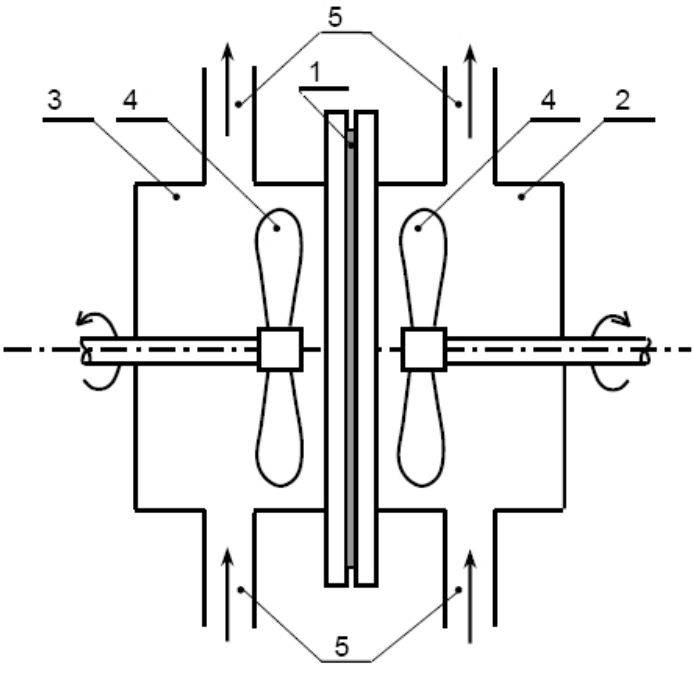
Fig. 1 Installation with two impellers. 1-membrane, 2-hot cell, 3-cold cell, 4-impellers,